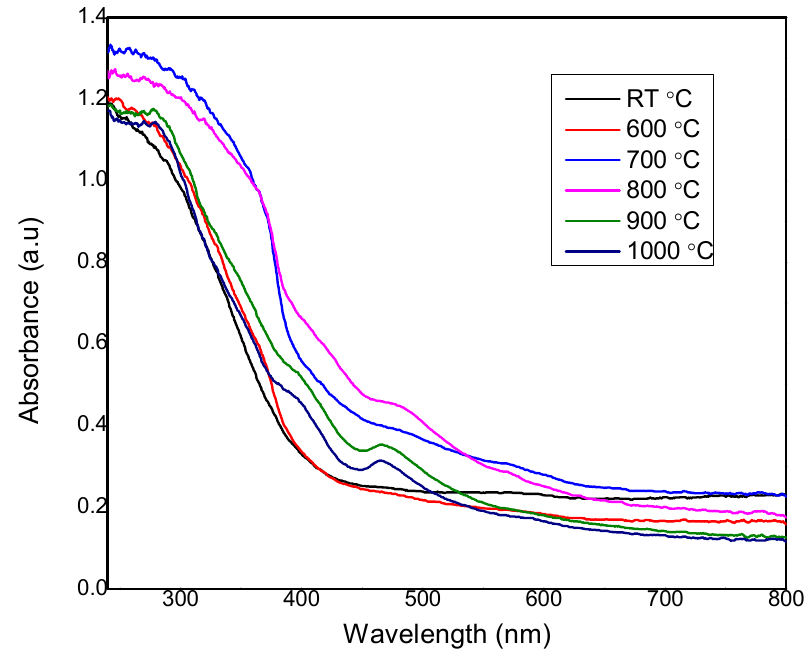
Figure 8. The absorbance spectrum of zinc silicate sintered at different sintering temperatures of RT, 600, 700, 800, 900, and 1000 °C.